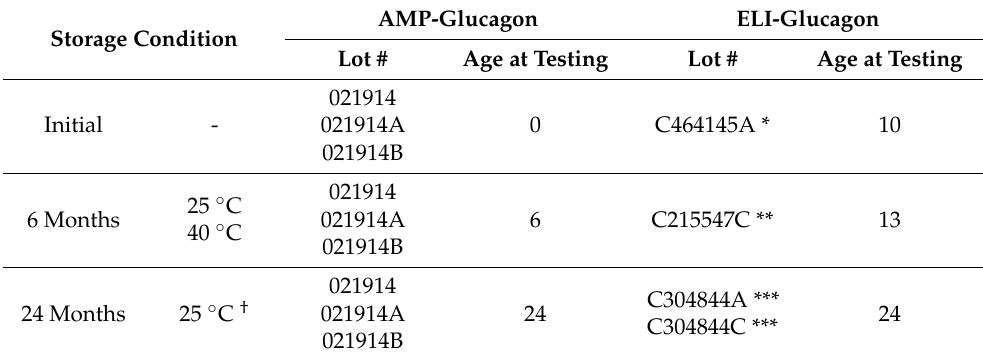
Table 1. Summary of the synthetic and recombinant glucagon samples tested. Storage Condition